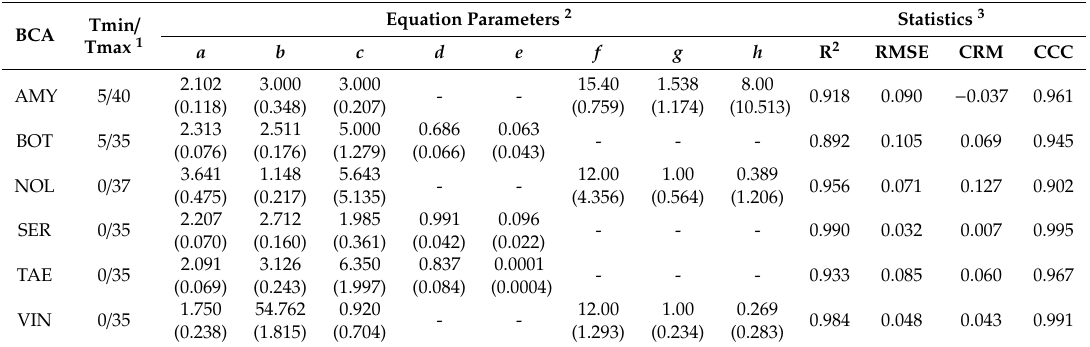
Table 2. Parameters of Equations (1) and (3) for the six BCAs, and statistics for goodness-of-fit to real data.